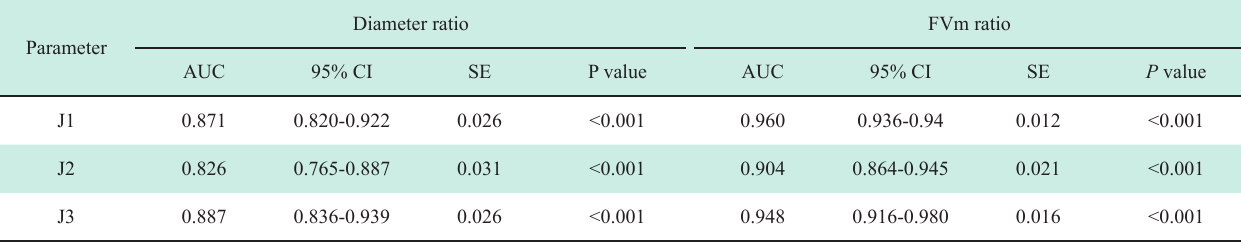
Table 2 The AUC of diameter ratio and FVm ratio (hypoplasia/dominant) of IJV hypoplasia